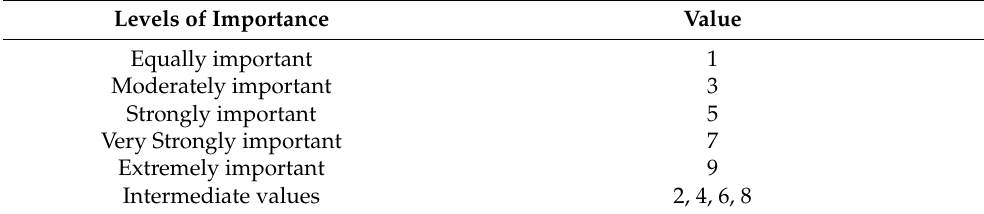
Table 1. The numerical values and their corresponding levels of importance. Levels of Importance Value Equally important 1 Moderately important 3 Strongly important 5 Very Strongly important 7 Extremely important 9 Intermediate values 2, 4, 6,